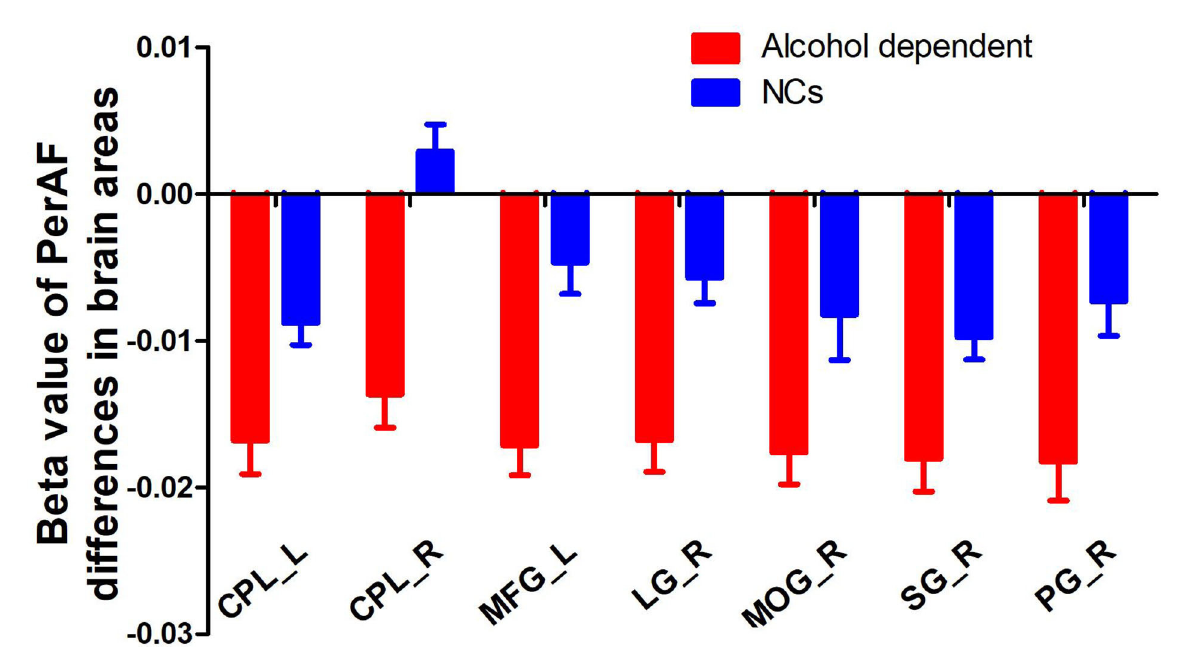
FIGURE3 Beta value of between-group differences in PerAF in regional brain areas. PerAF, percent amplitude of fluctuation; NCs, normal controls; R, right; L, left; CPL, cerebellum posterior lobe; MFG, medial frontal gyrus; LG, lingual gyrus; MOG, middle occipital gyrus; SG, supramarginal gyrus; PG, postcentral gyrus.